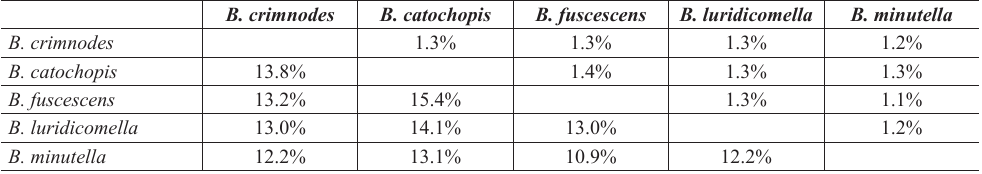
Table 2. Mean (below diagonal) and standard deviation (above diagonal) sequence divergence (uncorrected p-distances) of 658 bp fragment of cytochrome c oxidase I (COI) among pairs of species of Borkhausenia with sequences available on BOLD and